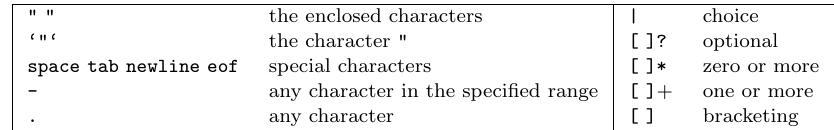
Fig. 3. Conventions for displaying the concrete